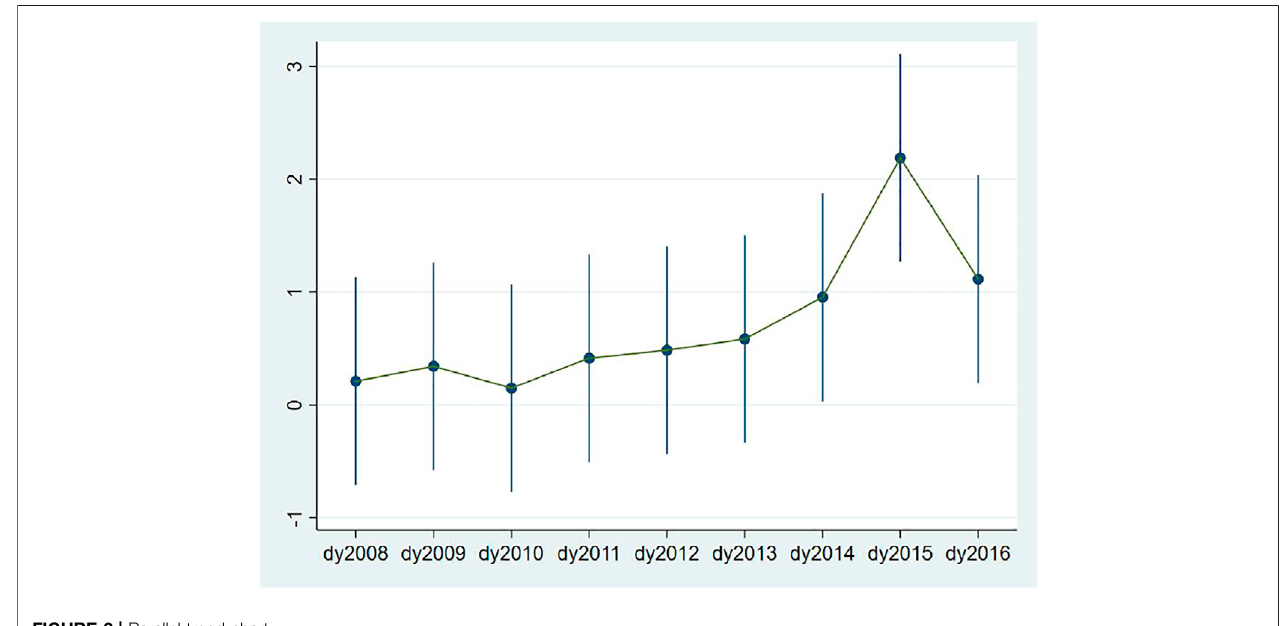
FIGURE 2 | Parallel trend chart.